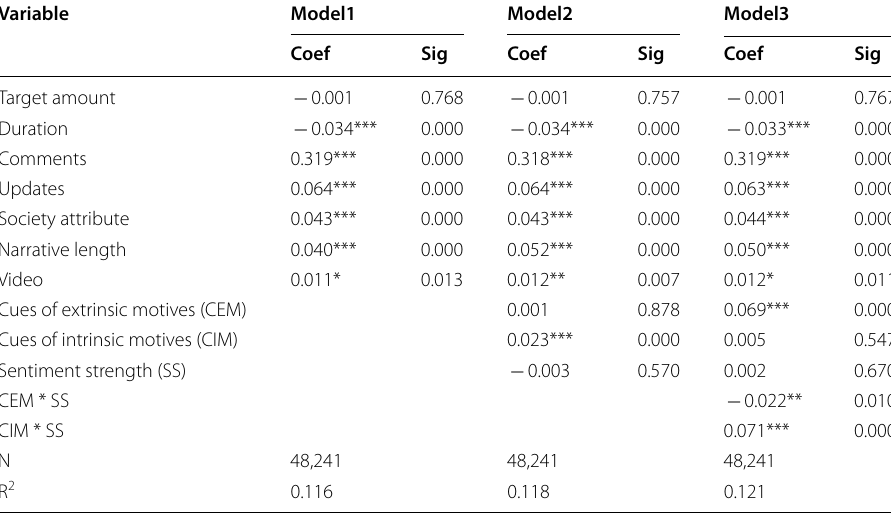
Table 8 Results of sentiment strength